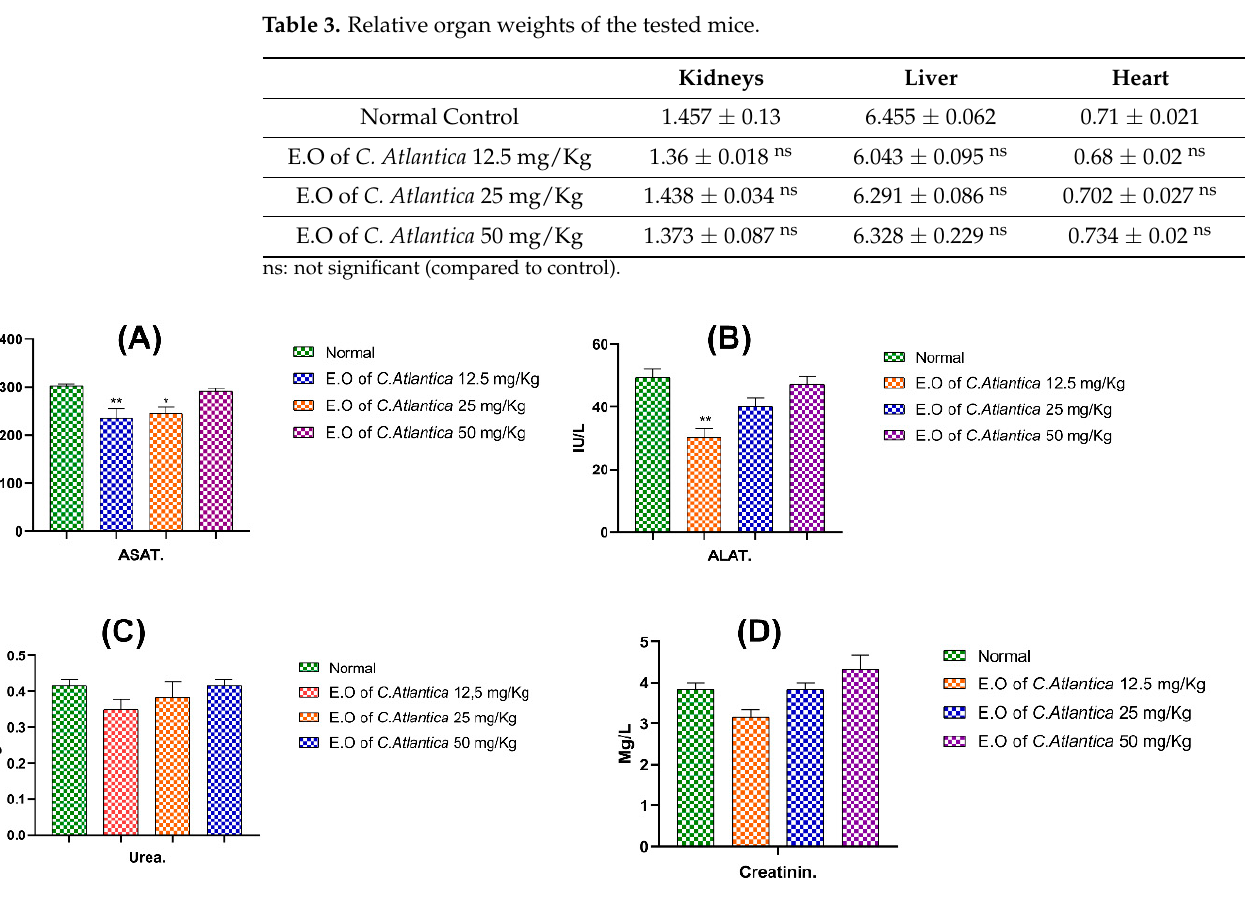
Figure 8. ( A ). The serum levels of ASAT; ( B ). The serum levels of ALAT; ( C ). The level of serum urea of control and treated mice ( D ). Serum creatinine level of control and treated mice. Values are expressed as mean ± SD ( n = 5). * p < 0.05, ** p < 0.01 compared to normal control.